Question: What form of chart is displayed?
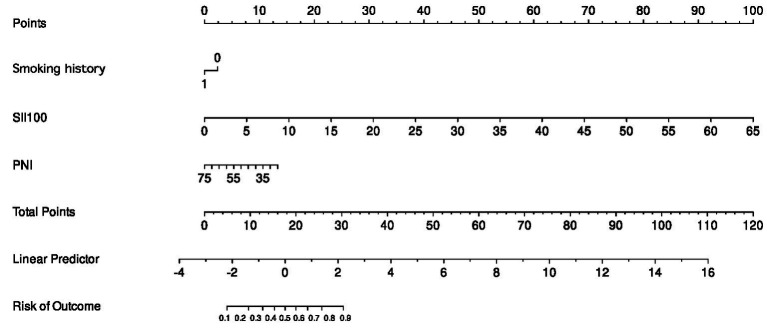
Answer: line